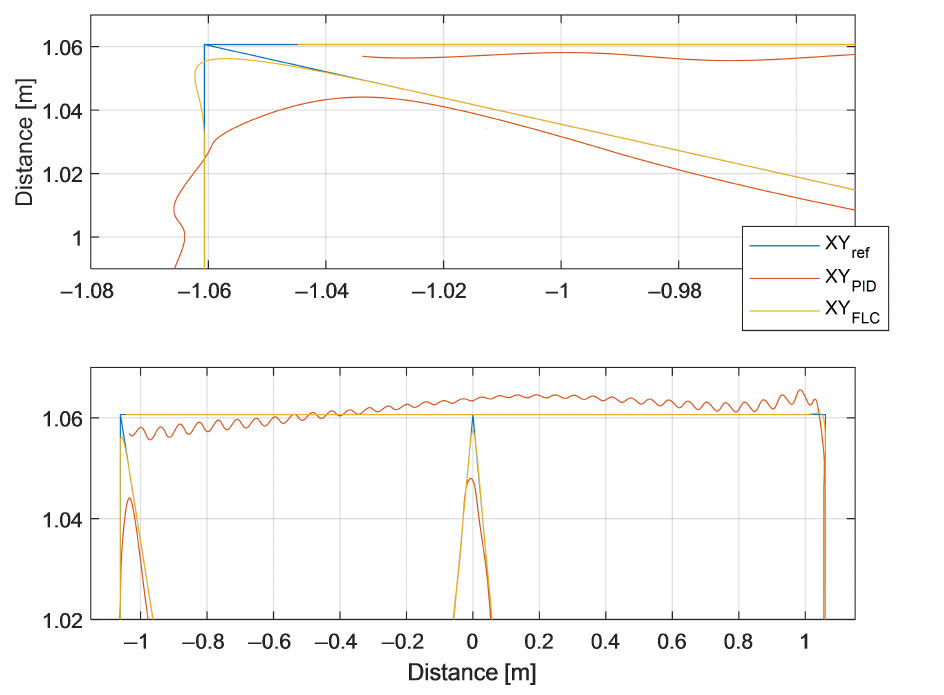
Figure 14. Zoom of previous